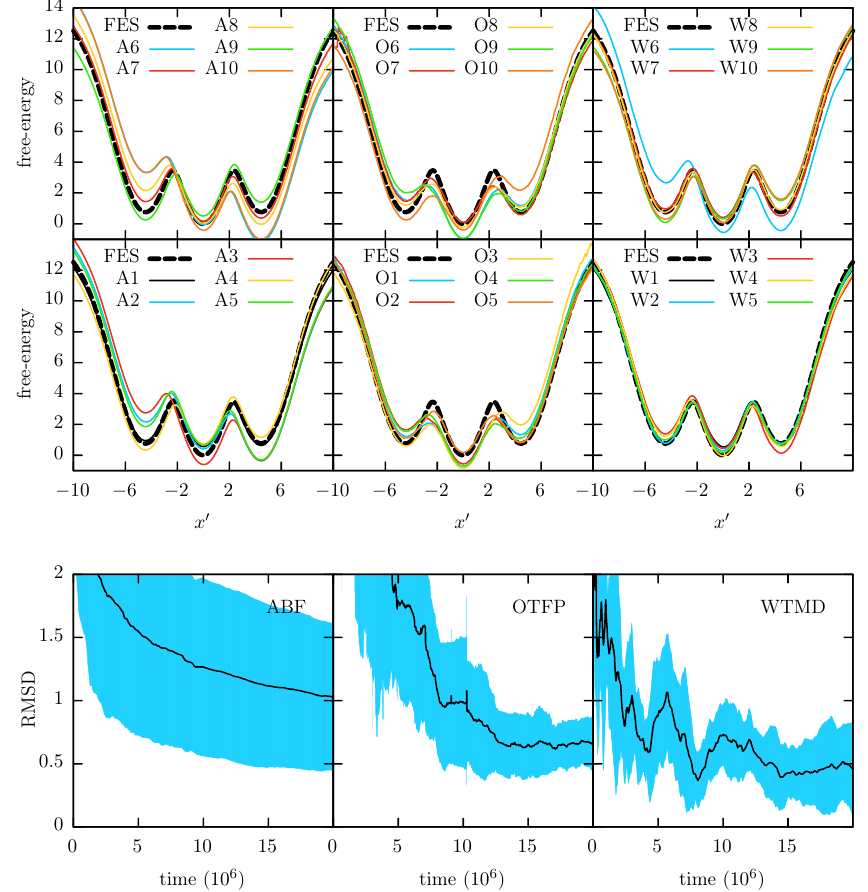
Figure 6. FEPs obtained using x (cid:48) as CV and 10 different simulations for each free energy method as indicated: A1–A10 for ABF, O1–O10 for OTFP and W1–W10 for WTMD. The average convergence profiles are also shown in the bottom of the figure. The light blue region corresponds to one standard deviation. This profiles shows the expected convergence of each individual simulation and should not be confused with the convergence of the average FEP profile. For the average FEP and the individual convergence profiles see Figure S8 in the Supplementary